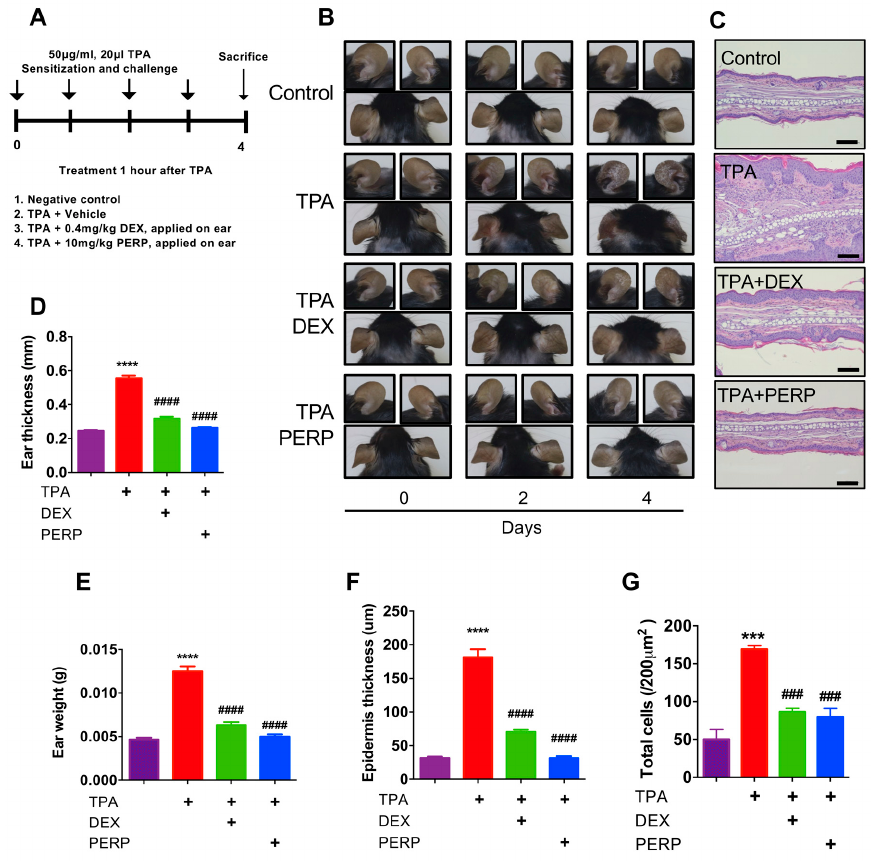
Figure 2. Perphenazine attenuates TPA-induced acute dermatitis model in mice. ( A ) Schematic diagram of TPA-induced animal model. Four groups: untreated controls, TPA only and mice treated with DEX (Dexamethasone) or Perphenazine (PERP) one hour after every TPA challenge ( n = 7). ( B ) Representative pictures of mouse ears collected at zero, two, and four days. ( C ) Histological sections of ear biopsies were analyzed using H&E-stained sections. Original magnification = X200. Scale bar = 100 um. ( D ) Ear thickness and ( E ) Ear weight. ( F ) Epidermal thickness of the ear skin. ( G ) Total infiltrated cells were counted. Data are presented as mean ± SEM and analyzed by one-way ANOVA (*** p < 0.005 and **** p < 0.001 vs. control) and (### p < 0.005 and #### p < 0.001 vs. TPA).